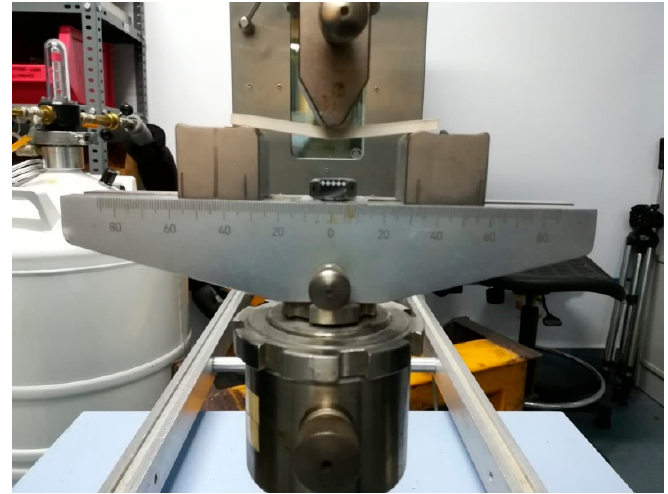
Figure 15. Flexural test according to UNE-EN-ISO 178-2011 standards.